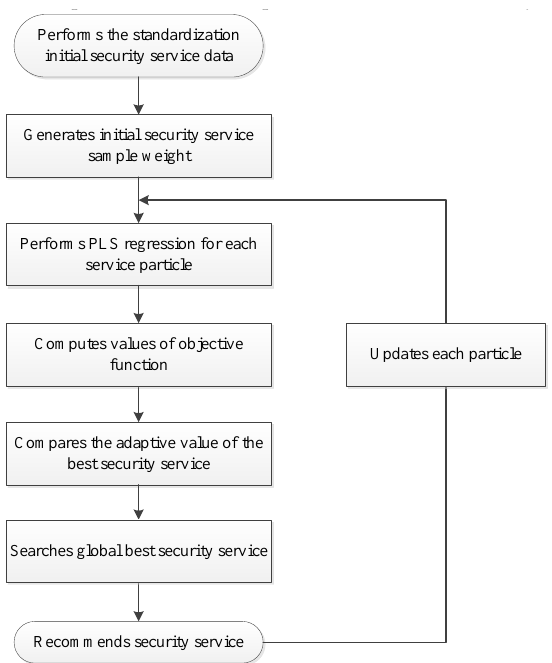
Figure 3. Process of the security service recommendation.